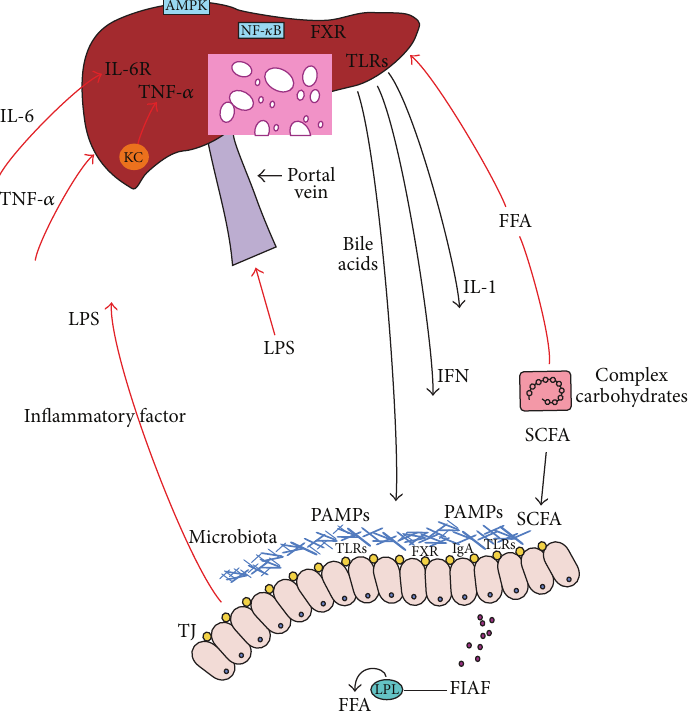
Figure 1: Gut-liver axis in